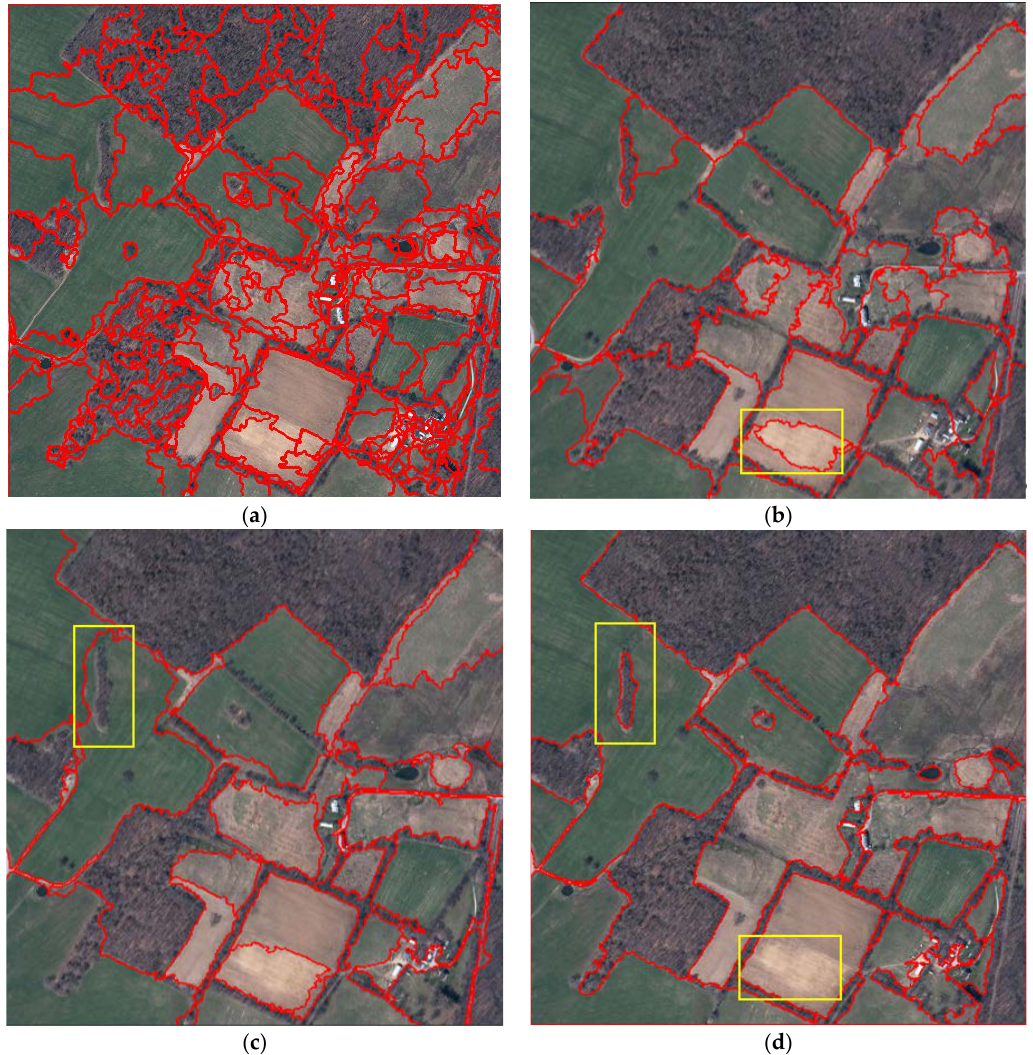
Figure 11. Segmentation results produced by different methods for the Montgomery aerial image (T3): ( a ) WTS; ( b ) MS; ( c ) MRS; ( d ) MMHS.